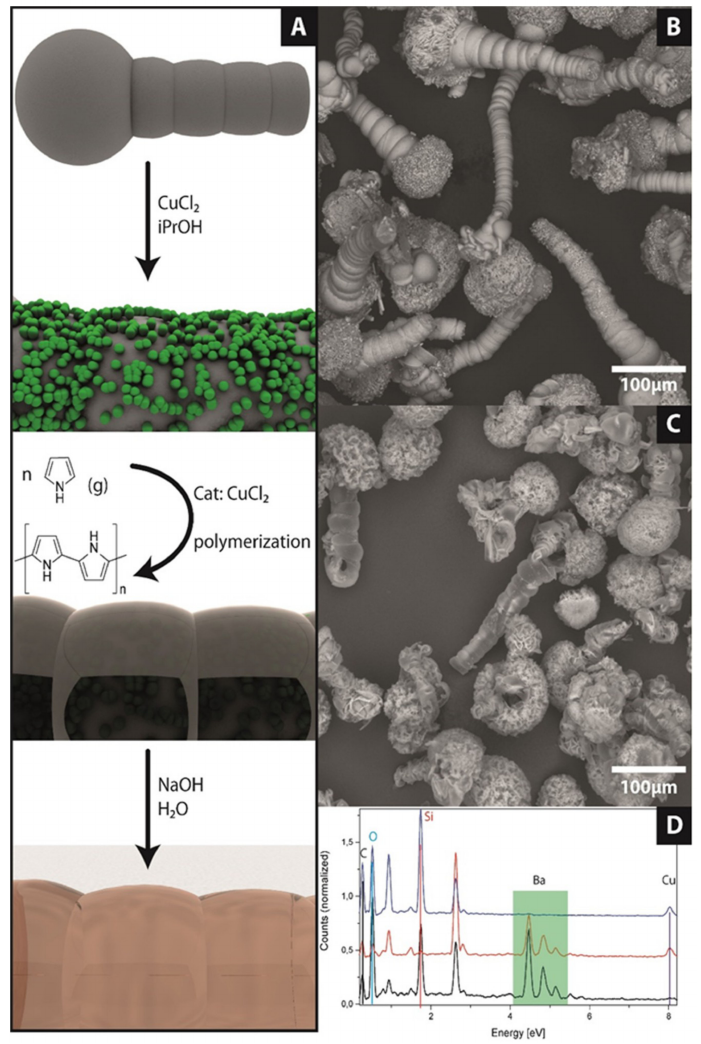
Figure 3. ( A ) Schematic illustration of the pPy route to preserve biomorphic structures. CuCl 2 crystals are attached from iPrOH solution on the surface of a naked biomorph. In the next step pyrrole diffuses via the gas phase onto the surface and is polymerized by CuCl 2 . After the polymerization the inner parts can be removed by sodium hydroxide solution. ( B ) SEM image of catalyst crystals attached on biomorph worms. ( C ) Inverse biomorphs after Polymerization of pyrrole (Py) and removal of the inner part. ( D ) Energy dispersive X-ray (EDX) spectra of the different steps to plastic biomorphs. The untreated biomorphs are shown in black. Naked biomorphs with CuCl 2 in red and the final inverse biomorphs without inorganics are shown in